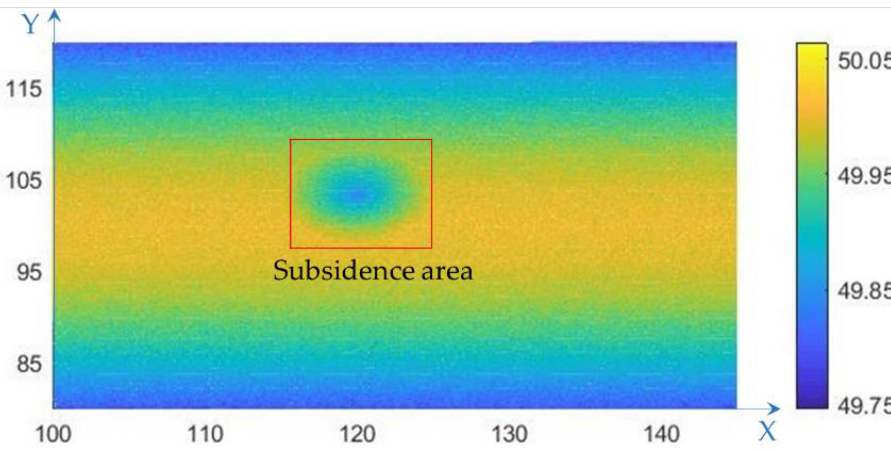
Figure 4. Simulated road surface point cloud data (m).